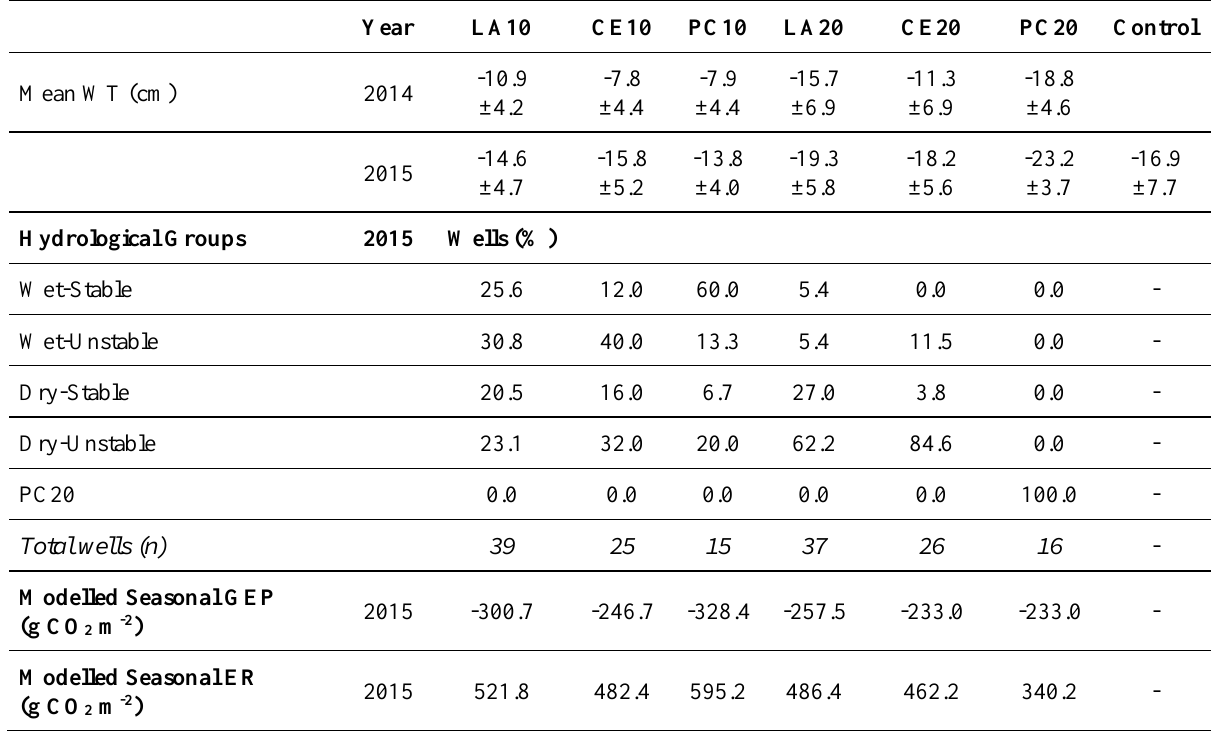
Table 3. WT measurements by year and hydrological group (± standard error), n = 13 (2014), n = 16 (2015), except the control n = 13. Basins had different numbers of wells, and each well was coded according to hydrological group, expressed as a percentage of the basin total. This was done to upscale basin CO into basin seasonal GEP and ER (CO m -2 2